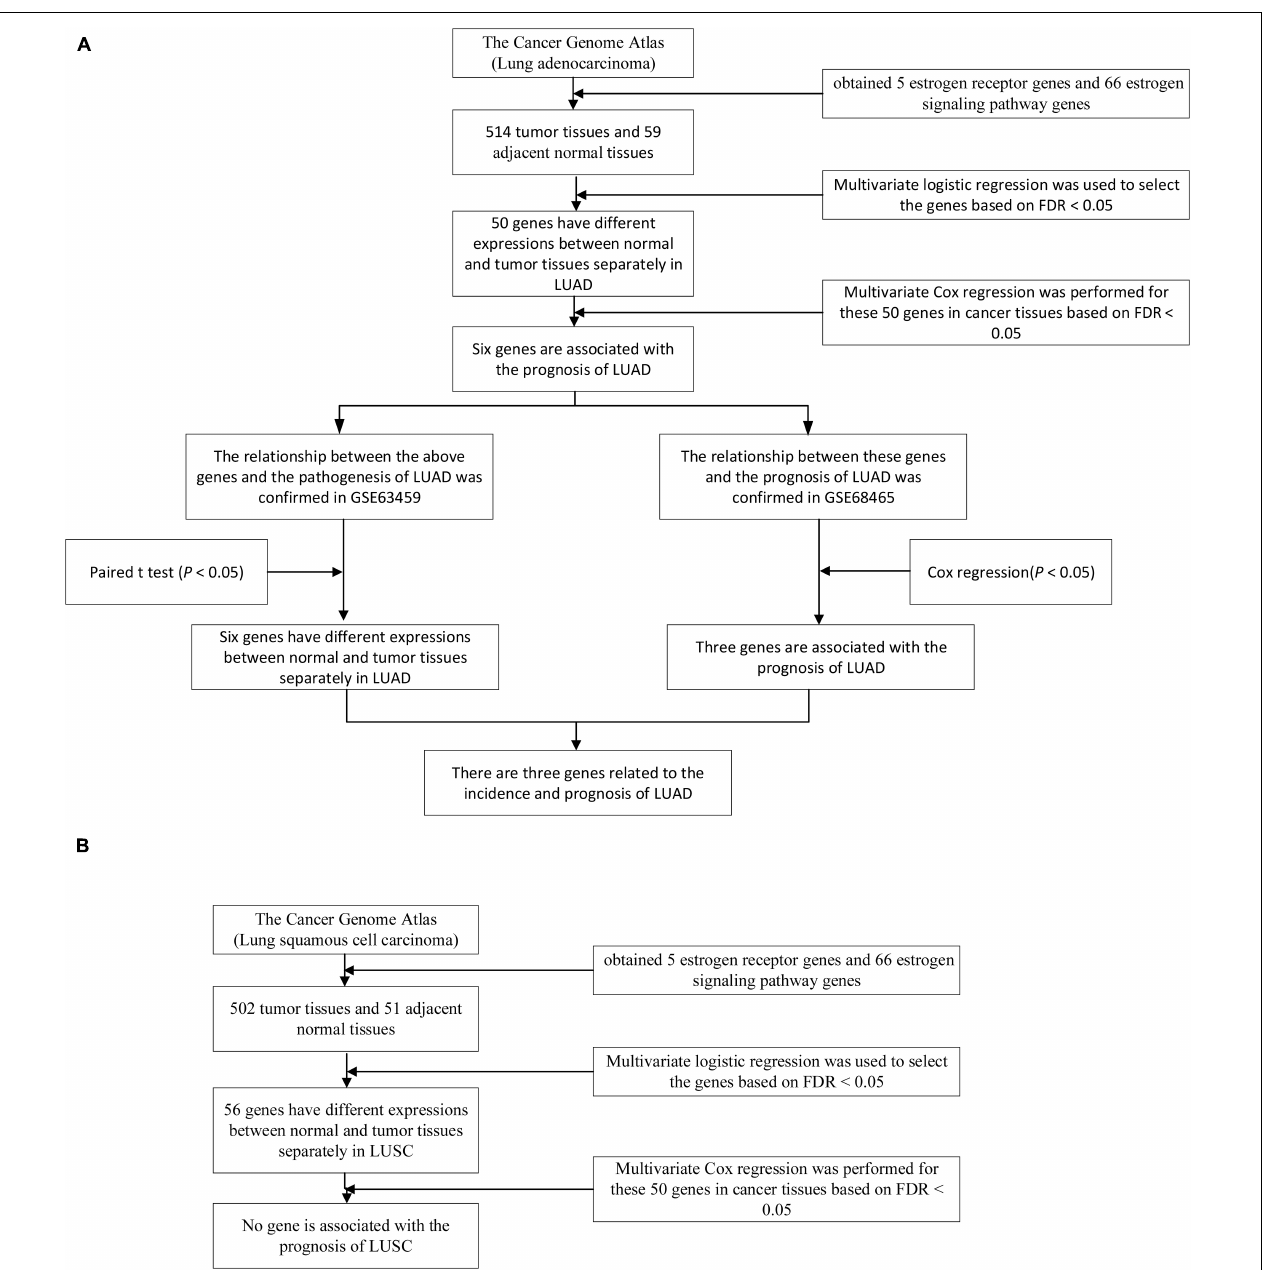
FIGURE 1 | The whole research process of LUAD and LUSC. (A) A total of 50 genes were differentially expressed between tumor and normal tissues in TCGA LUAD dataset and 6 genes were associated with the survival of LUAD patients under the FDR < 0.05. The diagnostic values and the prognostic values of the 6 genes were validated the in the GSE63459 and GSE68465 respectively. (B) A total of 56 genes were differentially expressed between tumor and normal tissues in TCGA LUSC dataset. None of the 56 genes was associated with the survival of LUSC patients under the FDR < 0.05. Therefore, the validation steps were not performed for